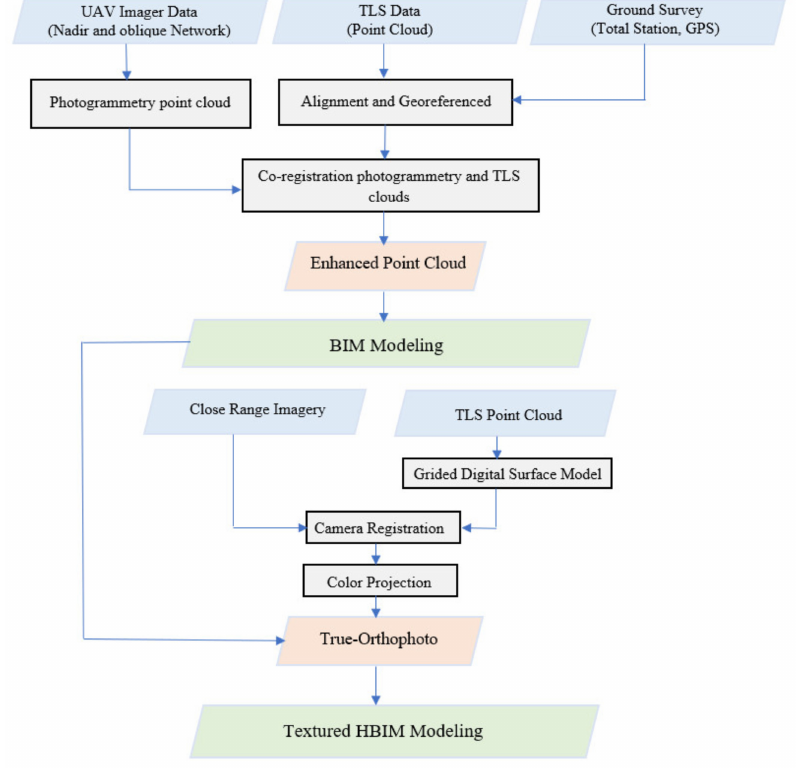
Figure 1. As-textured As-Built BIM